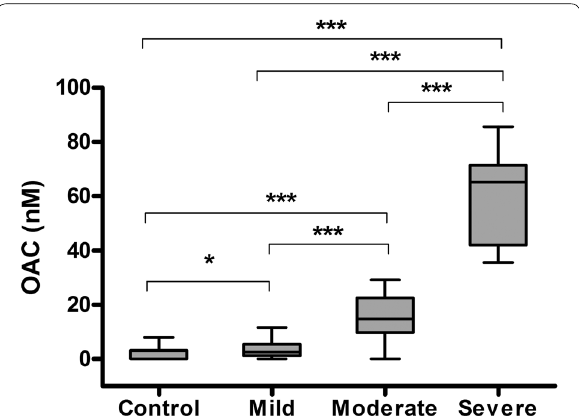
Fig. 2 Oleic acid chlorohydrin levels (nM) measured on admission in plasma of patients with acute pancreatitis that finally evolved into different disease severities. OAC oleic acid chlorohydrin; * P < 0.05; *** P < 0.001. Level of significance according to Bonferroni correction: